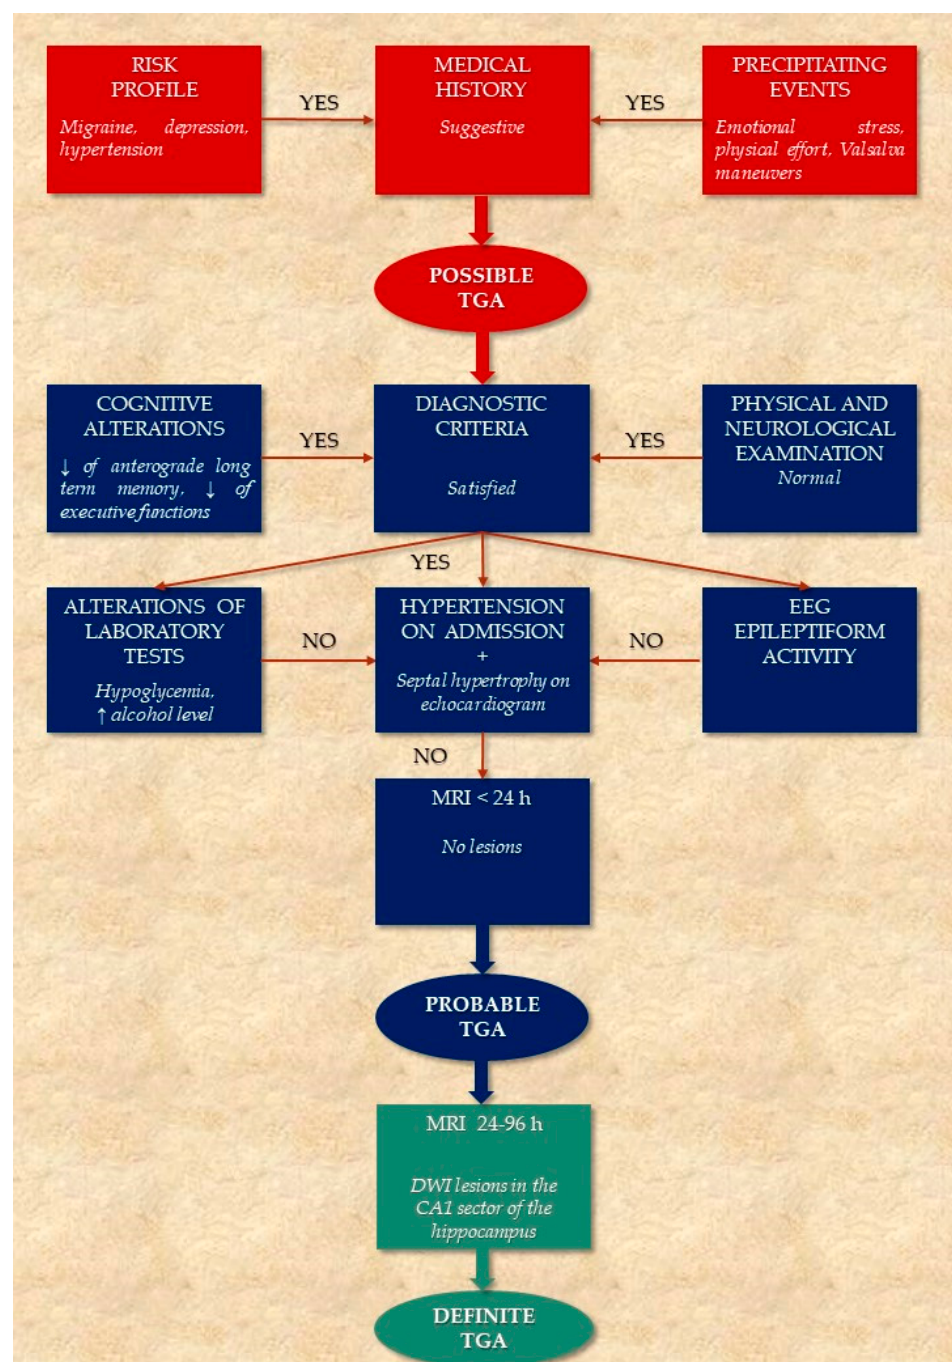
Figure 3. Algorithm for the diagnostic workup of TGA.